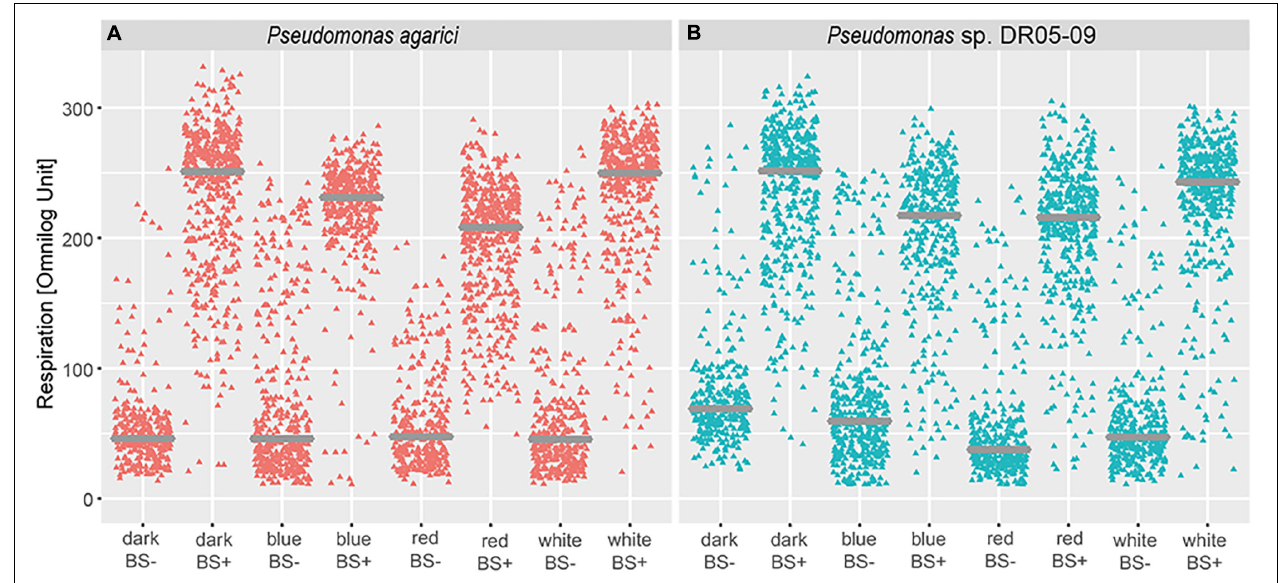
FIGURE 5 | Impact of light regime (dark incubation or incubation under blue, red, or white LED light) on biosurfactant formation of Pseudomonas agarici and Pseudomonas sp. DR 5-09. (A,B) display mean substrate utilization (expressed as Omnilog values) depending on surface activity of the suspensions (using drop collapse test) at the end of the incubation period by P. agarici and Pseudomonas sp. DR 5-09, respectively. BS + and BS- indicate positive and negative biosurfactant formation, respectively. TABLE 3 | Impact of light regime and substrate on putative biosurfactant formation by Pseudomonas agarici (normal font) and Pseudomonas sp. DR 5-09 (italics) as assessed by drop collapse test.